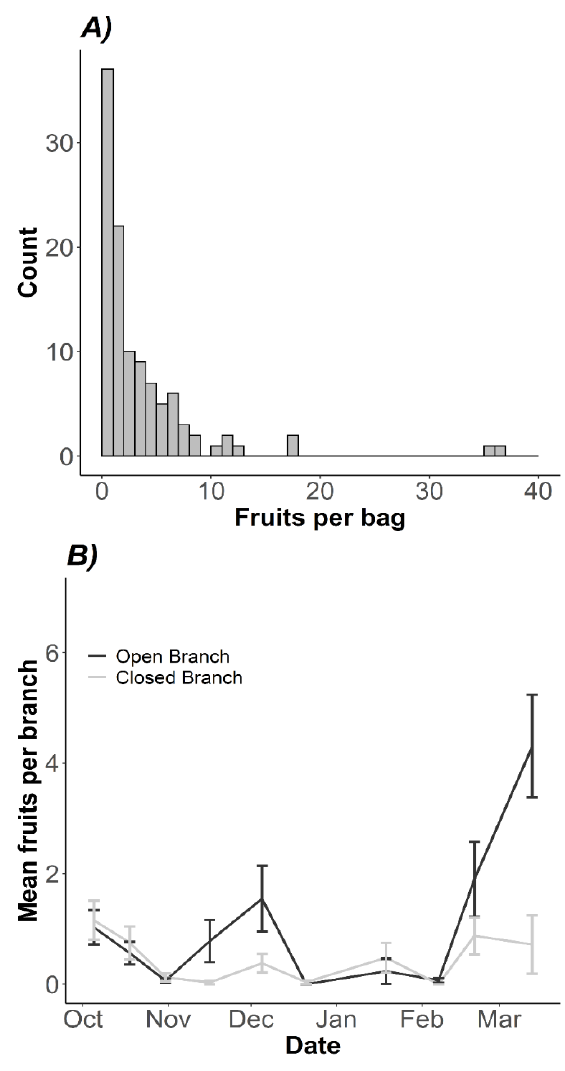
Figure 2. A) Histogram of the number of fruits produced per branch for branches fitted with pollinator exclusion bags (N = 190); B) Mean fruits per branch (± SE) in branches fitted with pollinator exclusion bags (closed branch) vs control branches fitted with bags that were cut open to al- low access by pollinators (open